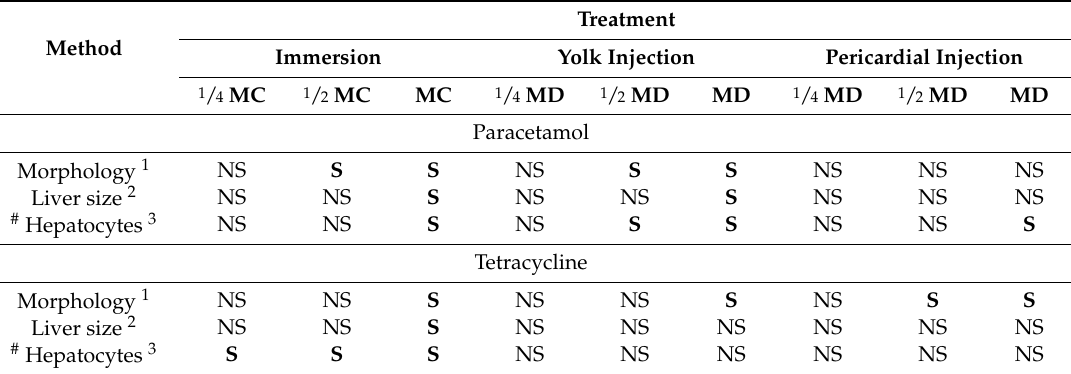
Table 4. Detection of compound-induced hepatotoxicity by the three